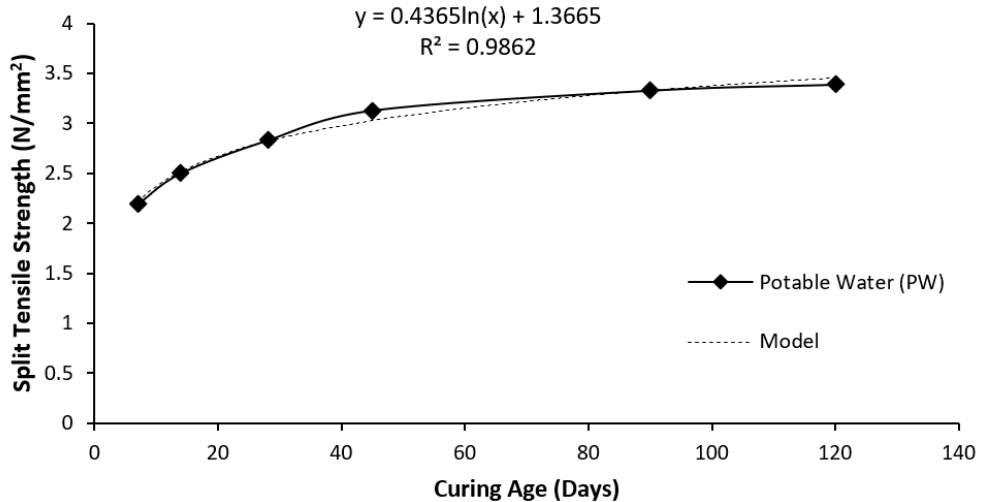
Figure 7. Split Tensile strength of concrete cured in potable water